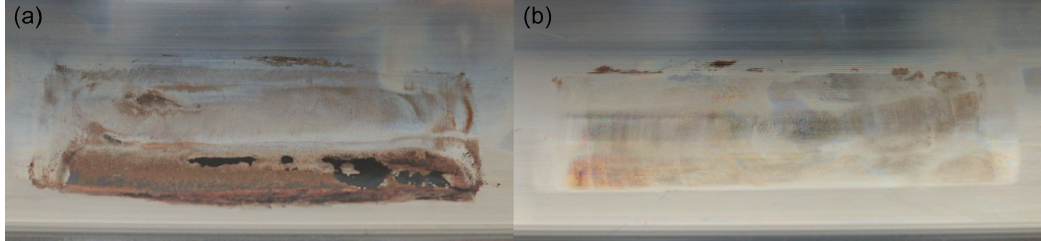
troduces Test ID III and IV, which have the same amplitude ( y 0 = 2 . 5 ◦ ) and a x/ 2 b ratio of 18.4 but a different velocity and a different frequency ( f left = 0 . 32 Hz, f right = 0 . 05